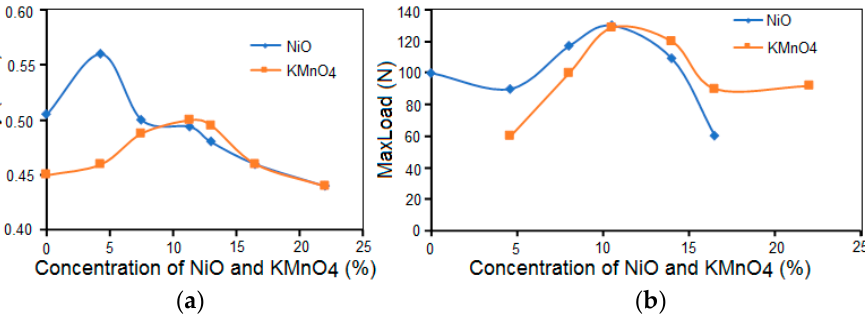
Figure 6. Influence of NiO and KMnO 4 concentration in the initial batches of Ni-Mn series on the velocity of combustion during SHS ( a ) and SHS catalysts compressive strength ( b ).